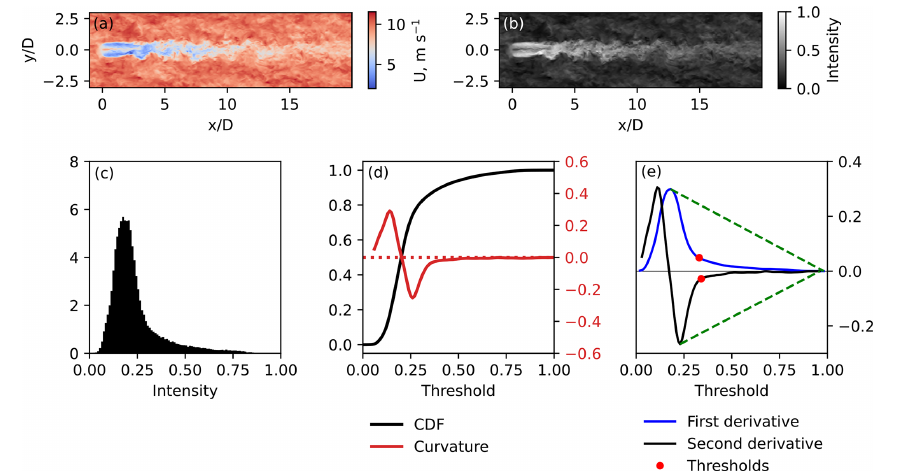
Figure 9. Sample LES wake and threshold detection. (a) Original instantaneous flow, (b) same flow normalized to the range of [0, 1], (c) the intensity histogram of the normalized data, (d) CDF of the normalized data and CDF plot curvature, and (e) first and second derivatives of the CDF and the estimated